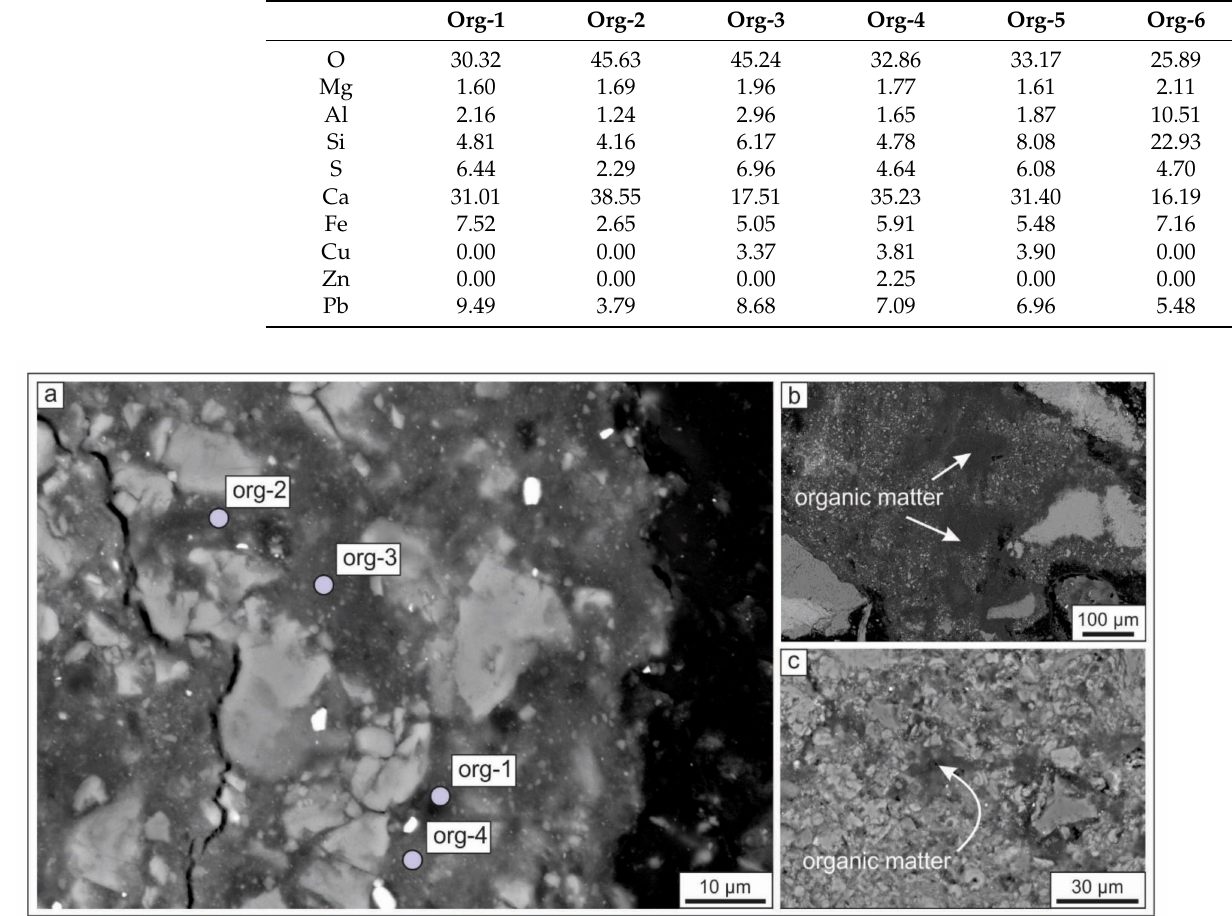
Figure 11. Organic matter forming the matrix between siliciclastic-carbonate grains ( a – c ). For the EDS elemental analysis of the points indicated in ( a ) refer to Table